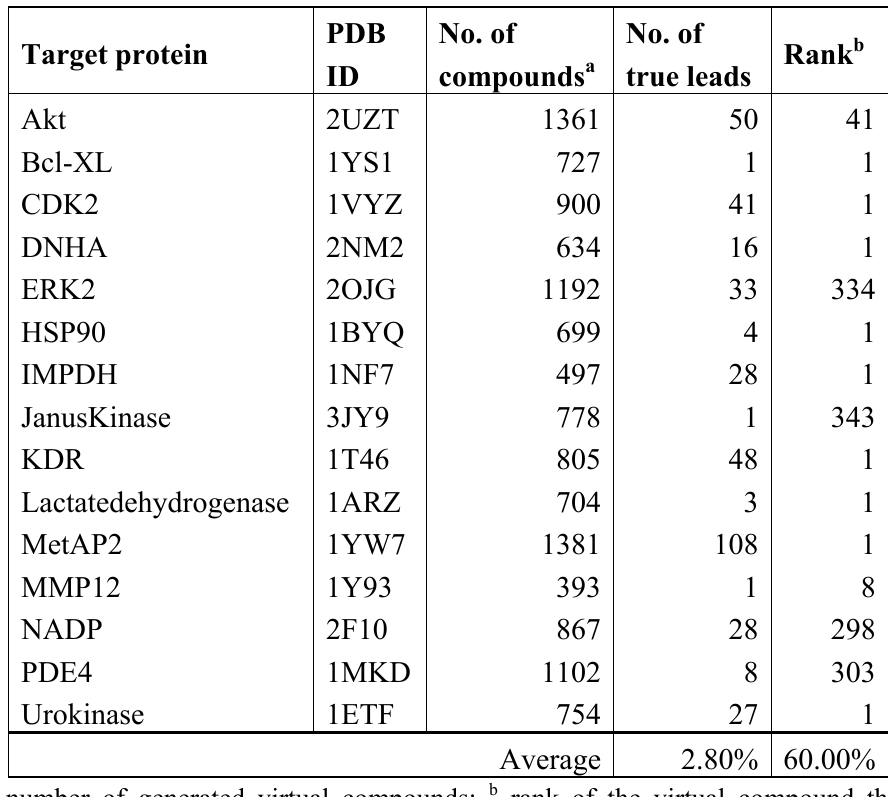
Table 3. Rank of the true lead